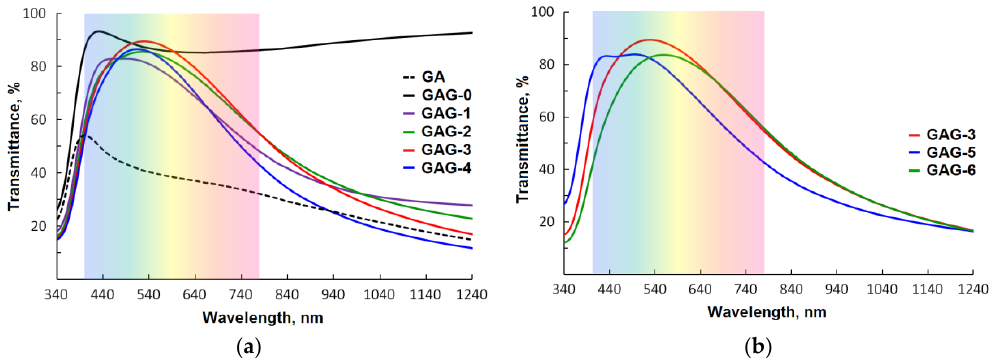
Figure 3. Optical transmittance spectra of the prepared multilayer structures: ( a ) with different Ag interlayer thicknesses; ( b ) with different thicknesses for the bottom and top GZO layers.